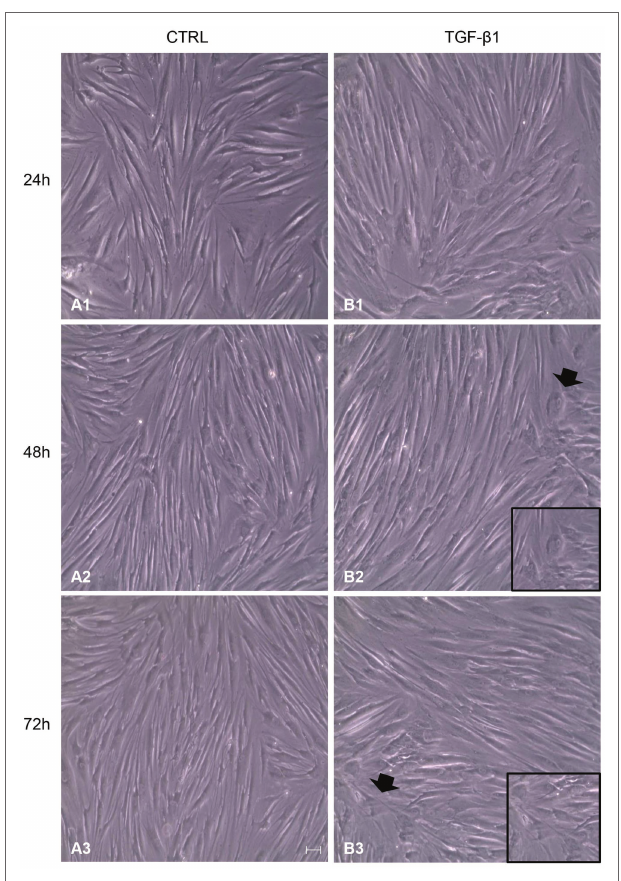
FIGURE 1 | Inverted optical microscopy images of untreated human gingival fibroblasts (hGFs; CTRL; A1-A3 ) compared to hGFs treated with Transforming Growth Factor-beta1 (TGF- β 1) (10 ng/ml) at 24, 48, and 72 h (B1-B3) . Scale bar: 50 μ m; magnification 10x.